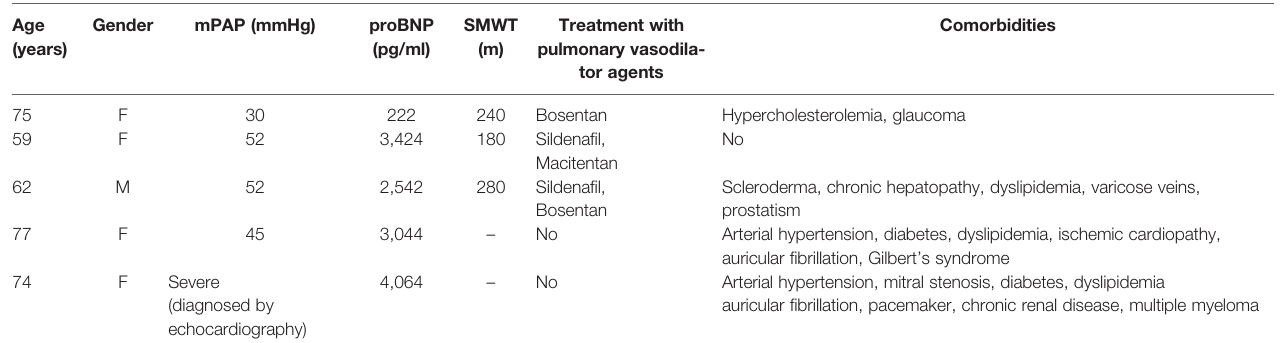
TABLE 1 | Characterization of the cohort of patients with